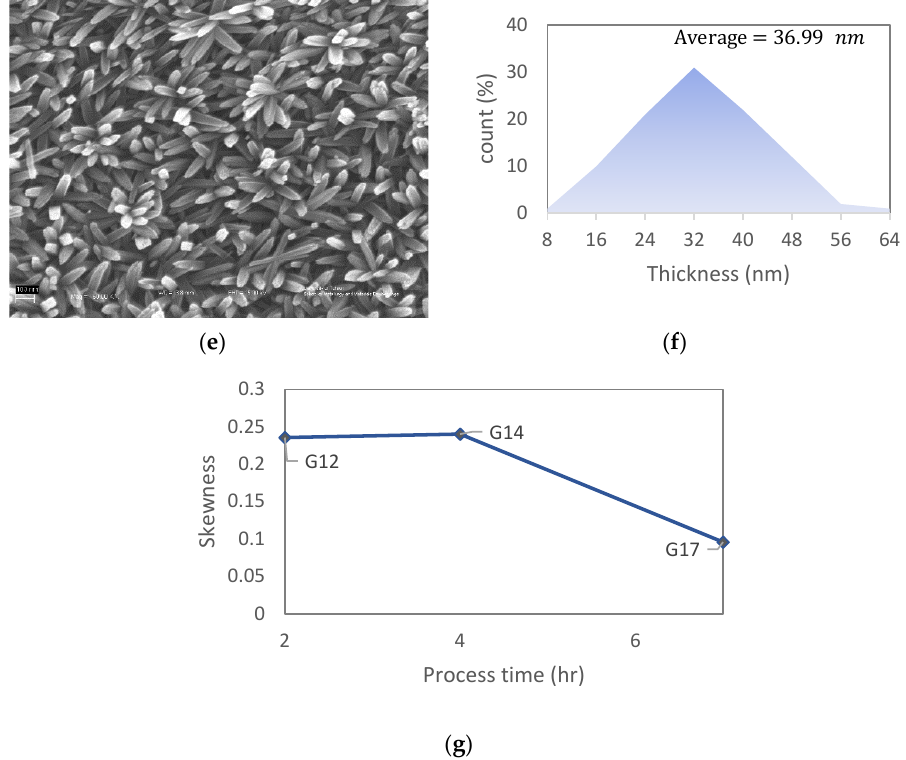
Figure 6. FESEM images of samples with: ( a ) 2 (Sample G12); ( c ) 4 (Sample G14); ( e ) 7 (Sample G17) hours of ACG process time along with digitally measured nano ‐ rod thickness histograms ( b , d , f ), respectively; ( g ) calculated skewness factor of Samples G12, G14, and G17 nano ‐ rod thickness histograms vs. process time.